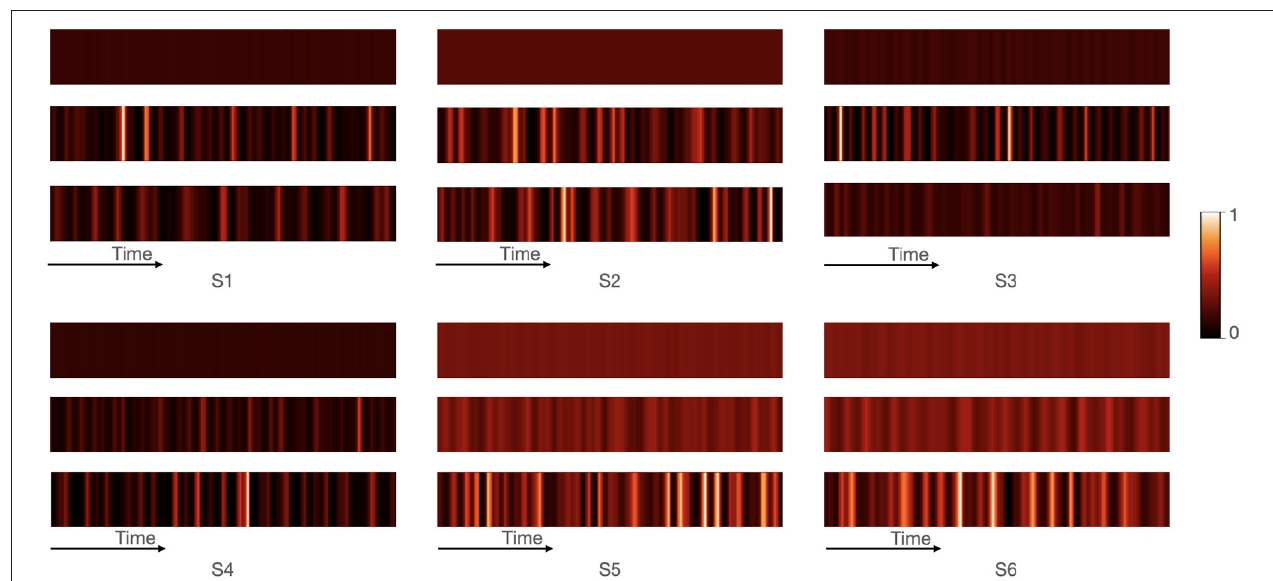
FIGURE 7 | Visualization of the cross-modal attention module from EEG to audio. Six samples were randomly chosen and defined as S1–S6. For S1–S3, the attended speaker is speaker A, while the attended speaker is speaker B in S4–S6. Each sample contains three attention matrices. The first row depicts attention weights before cross-modal attention model. The second and third row represents the attention weights of EEG that are adjusted according to the audio of speaker A and speaker B, respectively. In each matrix, the weights of all EEG channels are aggregated to presents the attention weights of EEG across time. The color of the cells describes the weight with lighter color corresponding to larger